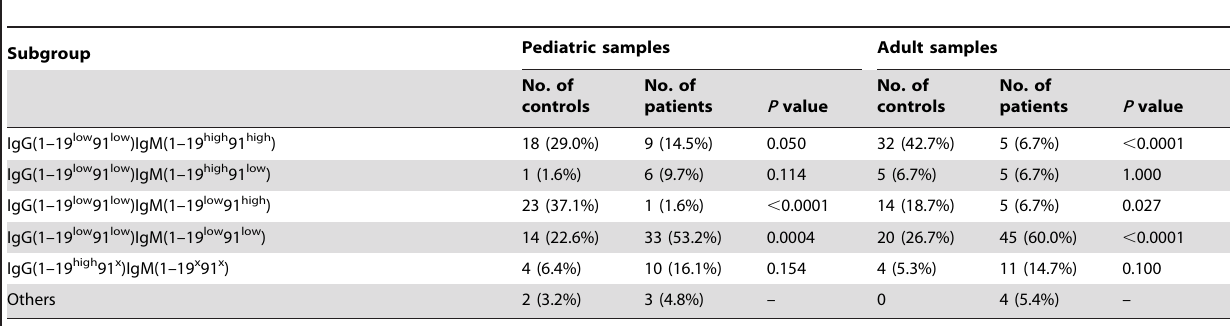
Table 1. Distribution of IgG and IgM anti-H3 1–19 and H3 1–19 K9me in SLE patients and healthy controls.